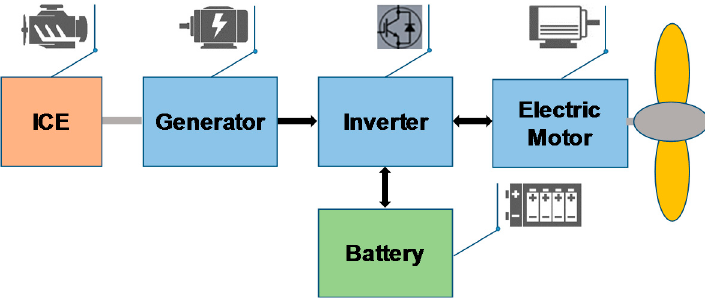
Figure 1. The basic architecture of a serial hybrid electric propulsion system.